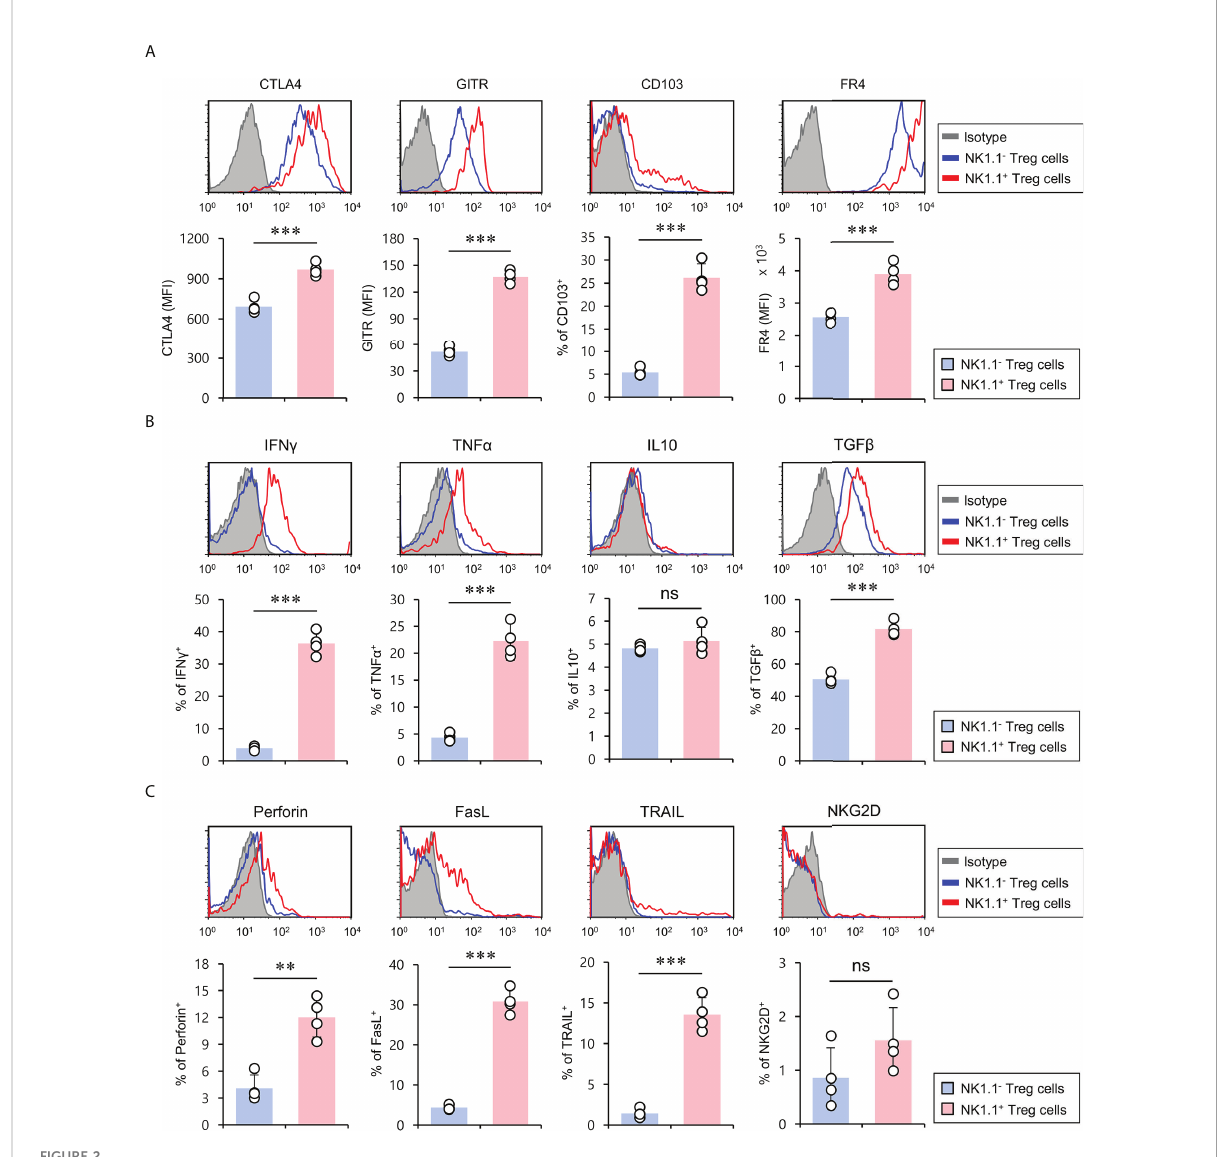
FIGURE 2 NK1.1 + Treg cells have the hybrid phenotype of Treg cells and NK cells. Splenic CD4 + T cells were isolated from 8-week-old CD1d KO B6 mice. (A) The expression of Treg cell-associated molecules (i.e., CTLA4, GITR, CD103, and FR4), (B) cytokines (i.e., IFN g , TNF a , IL10, and TGF b ), and (C) NK cell-associated molecules (i.e., perforin, FasL, TRAIL, and NKG2D) on NK1.1 - Treg (NK1.1 - CD4 + Foxp3 + ) and NK1.1 + Treg (NK1.1 + CD4 + Foxp3 + ) cells were evaluated by fl ow cytometry. Upper, representative FACS histogram; lower, summary fi gures. The mean values ± SD ( n = 4; per group in the experiment; Student ’ s t-test; ** p < 0.01, *** p < 0.001) are shown. One representative experiment of two experiments is shown. ns, not signi fi